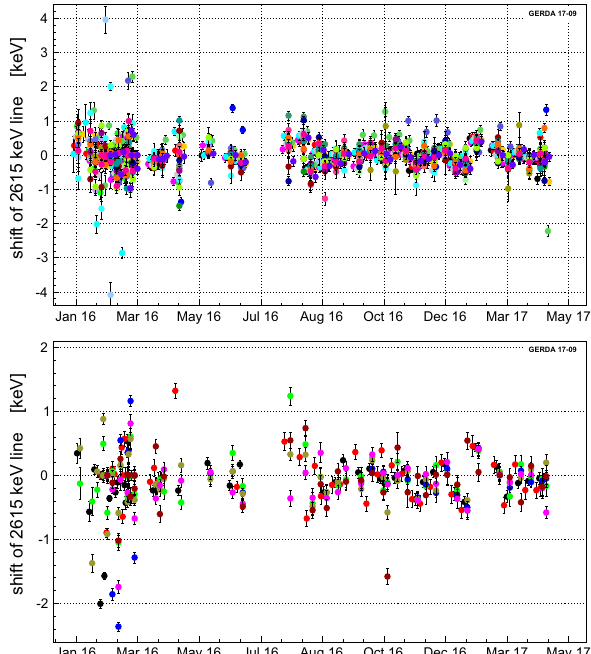
Fig. 22 Shift of the 2615keV peak of 208 Tl between consecutive cali- brations for indicated BEGe (top) and enriched coaxial detectors (bot- tom) by A/E > 1. Like in Phase I the A/E cut is calibrated with the data from the weekly calibrations with the 228 Th source. Events in the DEP are used as a proxy for 0 νββ events. The inset in 228 Th calibration spectrum (Fig. 27) illustrates the effect of the A/E ∼ 1 cut (yellow colored spectrum): the obvious survival of the DEP at 1593keV and the distinct suppression of the single gamma line of 212 Bi at